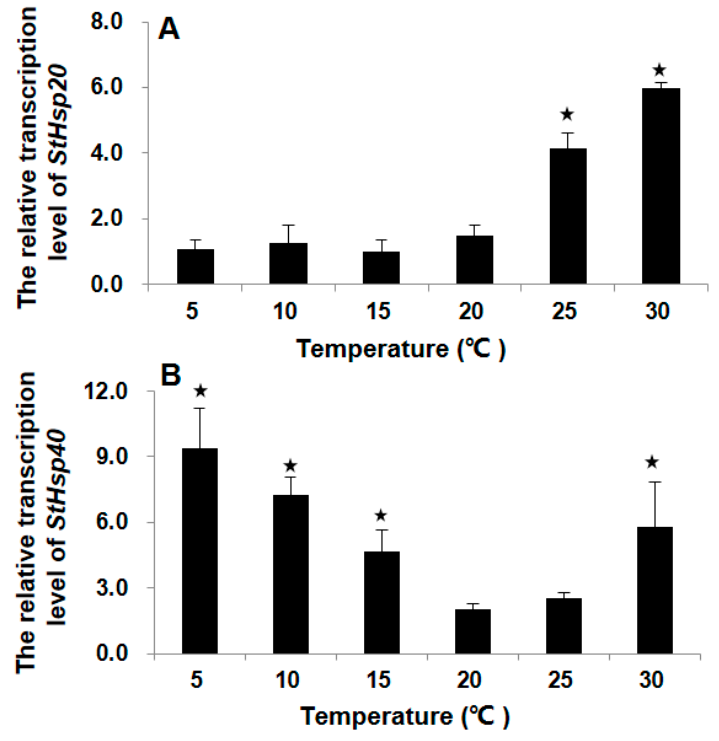
Figure 3. Transcription profiles of StHsp20 ( A ) and StHsp40 ( B ) in cells with different temperature treatments. The treatment groups that are significantly different ( p < 0.05) relative to the control (20 °C group) are noted with asterisks. Error bars represent the standard deviation from 3 replicates. Biology 2020 , 9 , x FOR PEER REVIEW